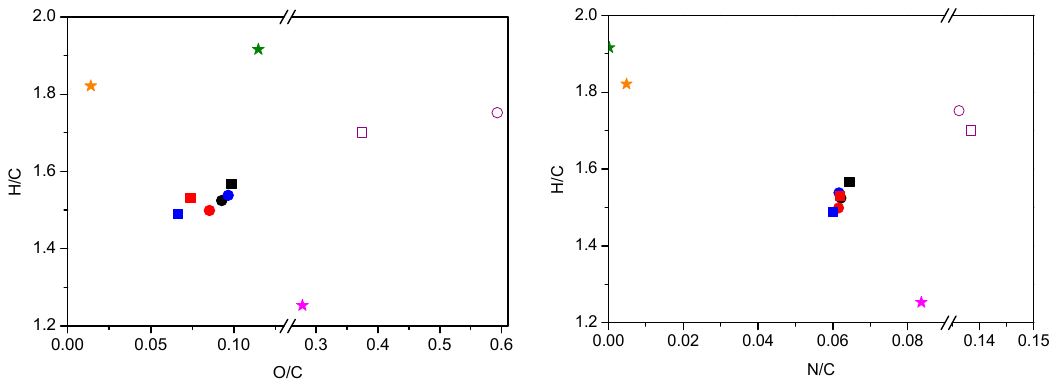
Figure 6. Van Krevelen diagrams for biocrude from HTL at 320 °C using B-90L (circles) at different times: 0 ( ● ), 10 ( ● ) and 30 min ( ● ) and B-1L (squares) at different times: 0 ( ■ ), 10 ( ■ ) and 30 min ( ■ ). For ( a ) and ( b ), values for B-90L ( ○ ) and b-1L ( □ ), reference diesel ( ★ ), biodiesel from N. gaditana oil ( ★ ) and biocrude from N. gaditana obtained through HTL at 320 °C and 10 min ( ★ ) [72]. B-1L and B-90L: P. tricornutum biomass cultivated in 1-L and 90-L bioreactors, respectively.